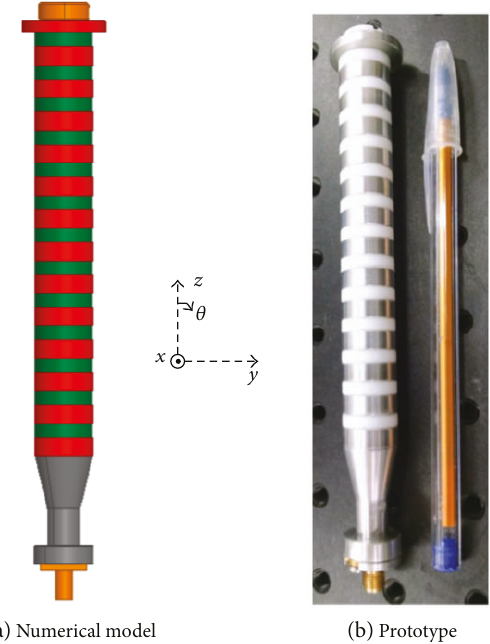
Figure 6: Omnidirectional ring-based